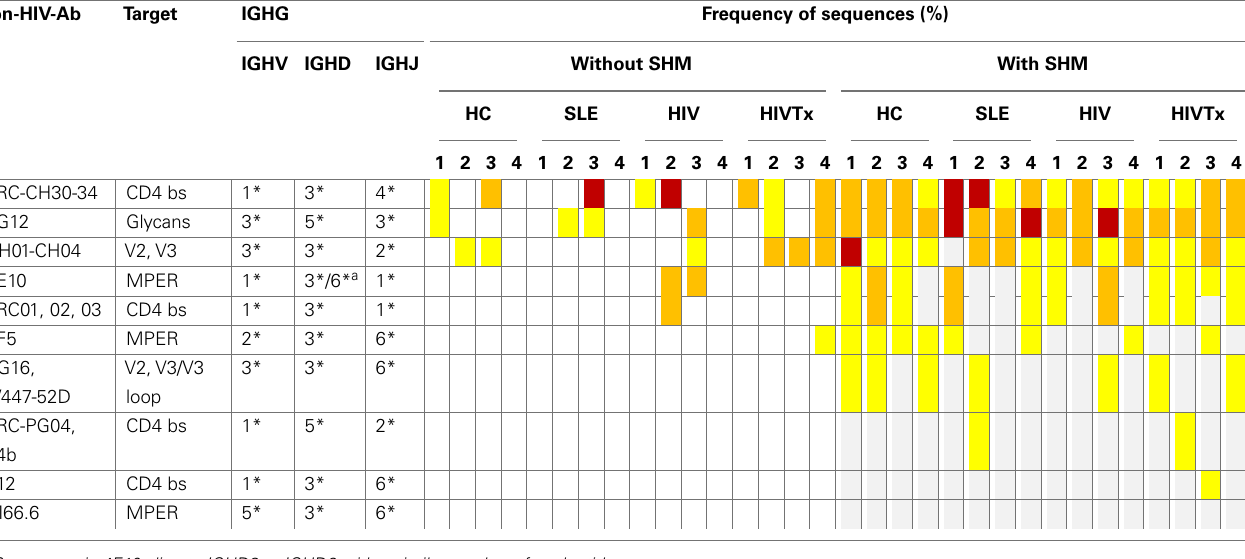
NA, not available.